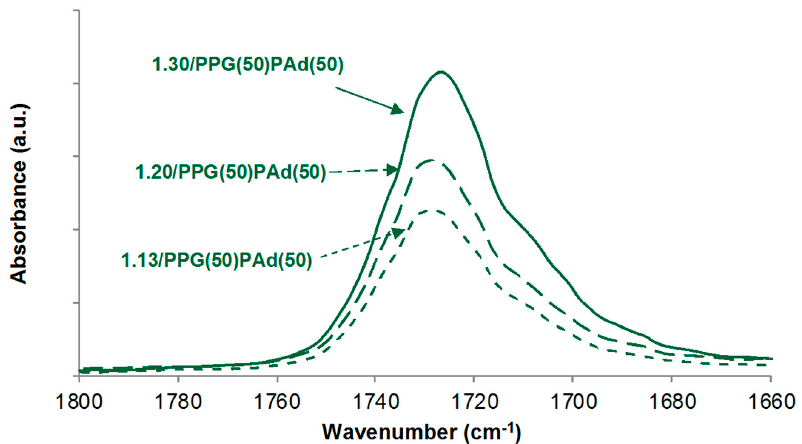
Figure A5. Carbonyl region of the ATR-IR spectra of the TPUs synthesized with 50 wt% PPG + 50